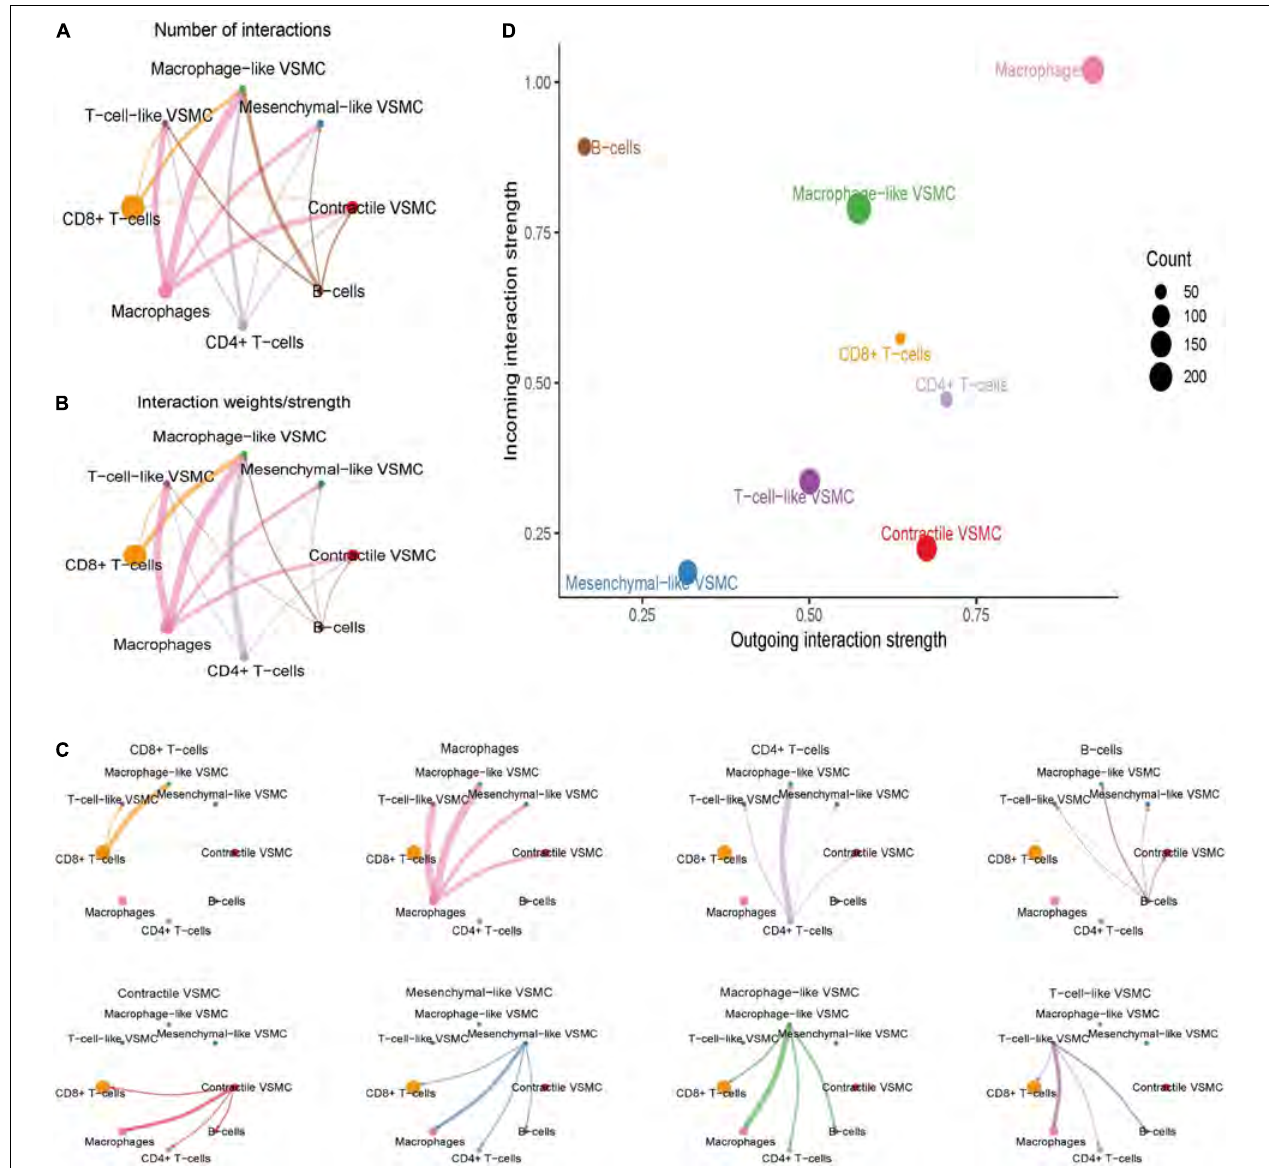
FIGURE 4 | Global cell–cell communication between immune cells and selected VSMC phenotypes. The overall intercellular interaction number (A) and weight (B) were visualized in the network. The line width represents the intensity. Subsequently, the communication intensity from each immune cell type to all VSMC phenotypes or from each VSMC phenotype to all immune cell types was visualized, respectively (C) . The incoming and outgoing communication capacity of each cell type (D) .